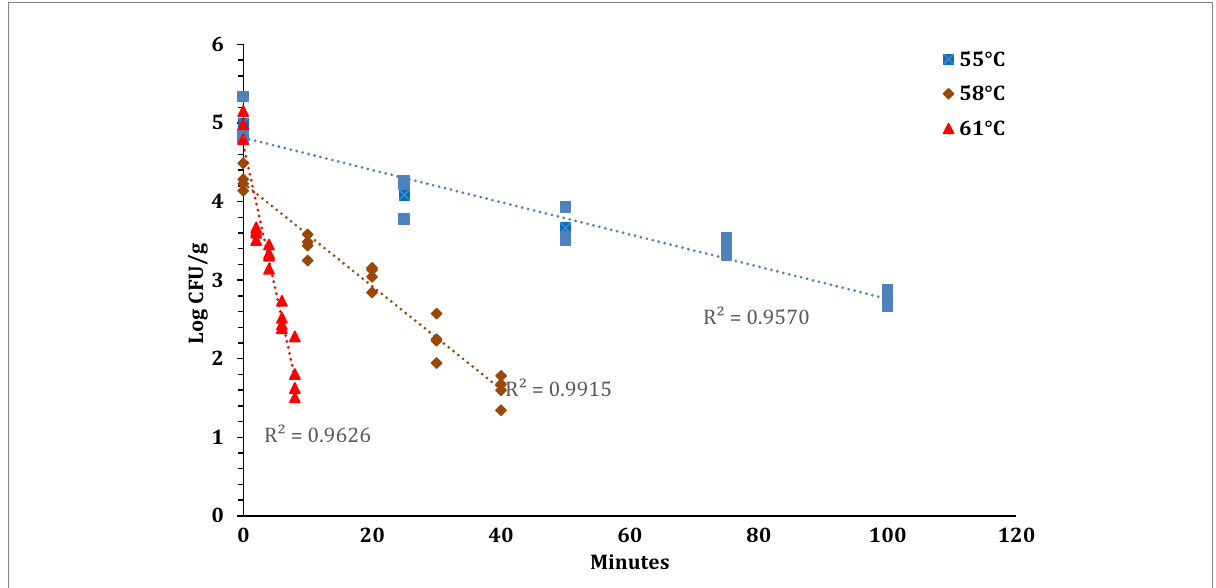
FIGURE 7 STEC population (Log CFU/g; mean and three replications) versus time (minutes) graphs used for calculating D -values at 57, 58, and 61 ° C.